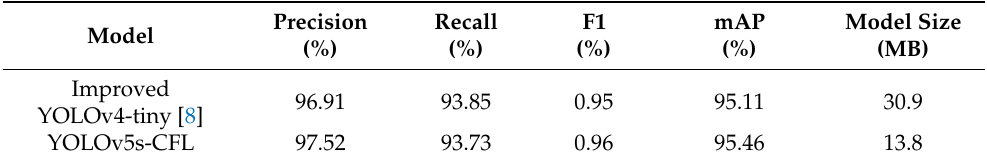
Table 4. The detection results of YOLOv5s-CFL and improved YOLOv4-tiny on green pepper dataset. Precision Model Improved YOLOv4-tiny